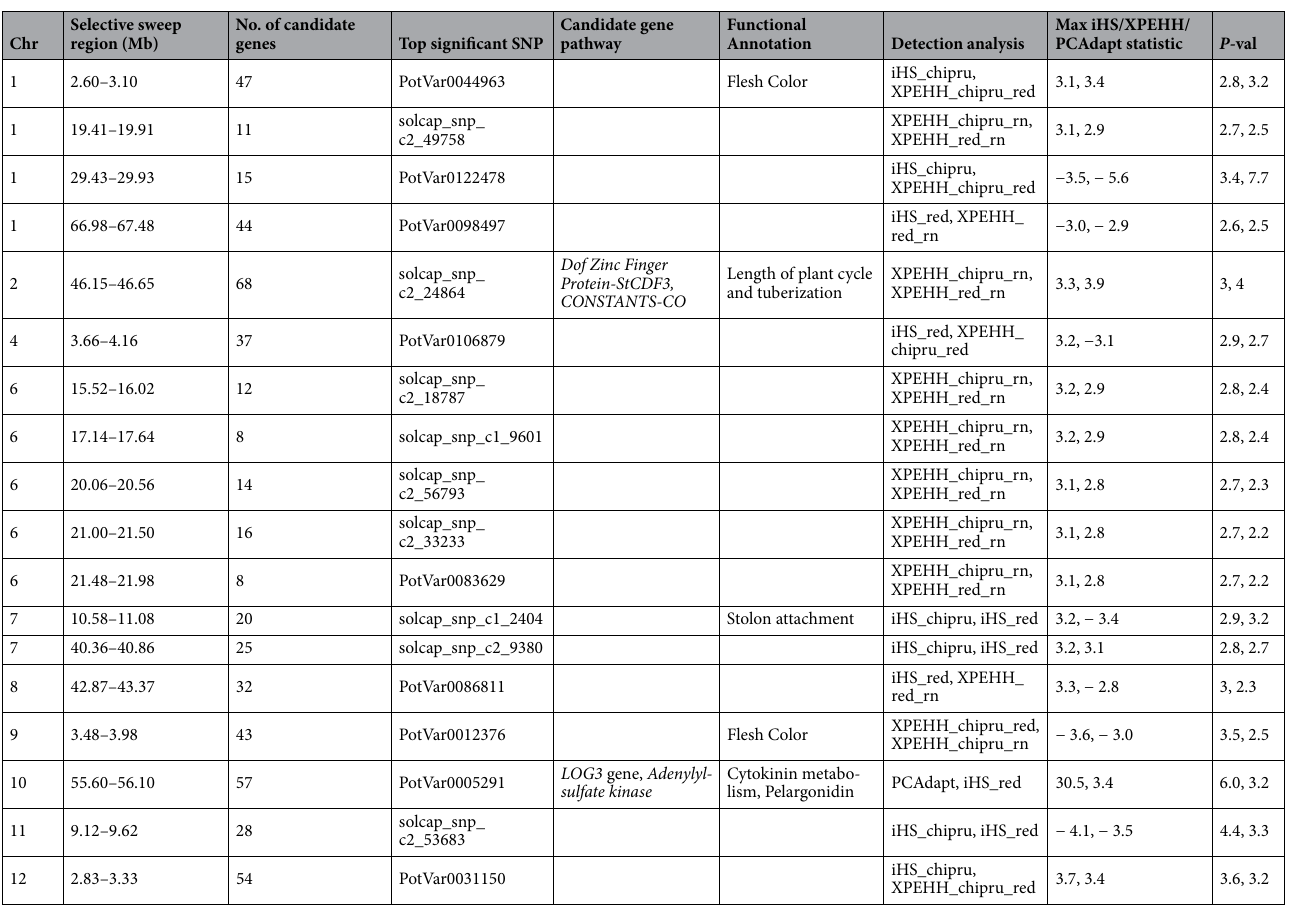
Table 1. Description of the candidate selective sweep regions detected using PCAdapt, iHS and XP-EHH analyses in potato.